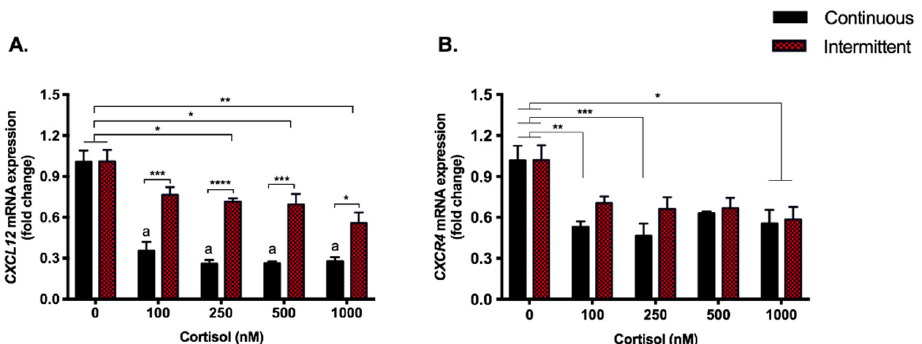
test. Interaction between (continuous or intermittent) exposure to cortisol and cortisol dose was found for CXCL12 ( p = 0.0027). Data are presented as mean ± SEM. * p < 0.05; ** p < 0.01; *** p < 0.001;